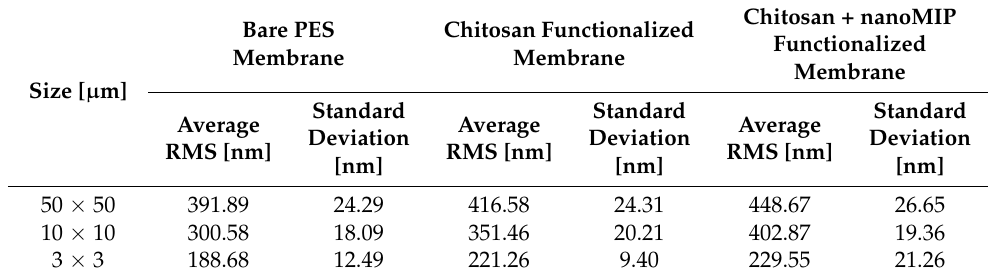
Table 2. RMS values after major functionalization steps.